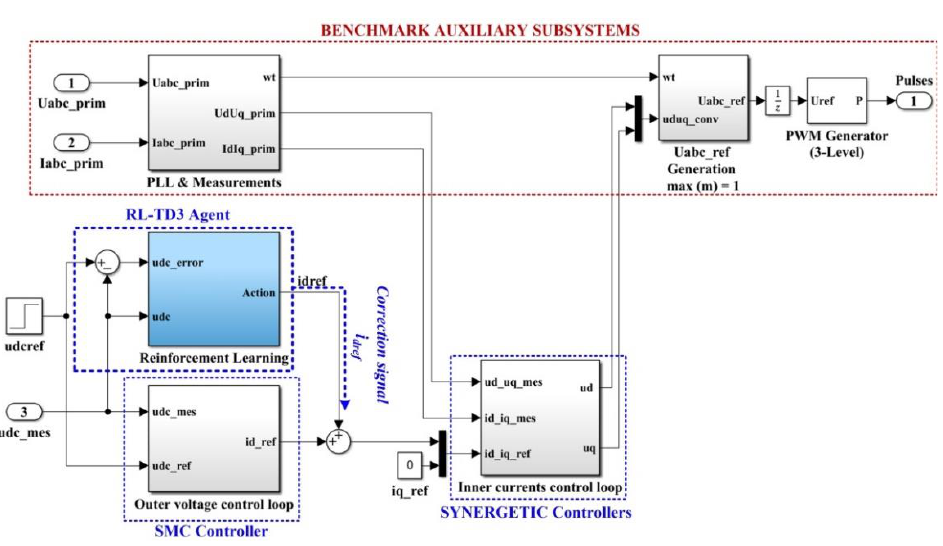
Figure 20. The model MATLAB Simulink implementation of the control system for the GC-PV array based on SMC and SYN controllers using the RL-TD3 agent for the correction of the control signals.